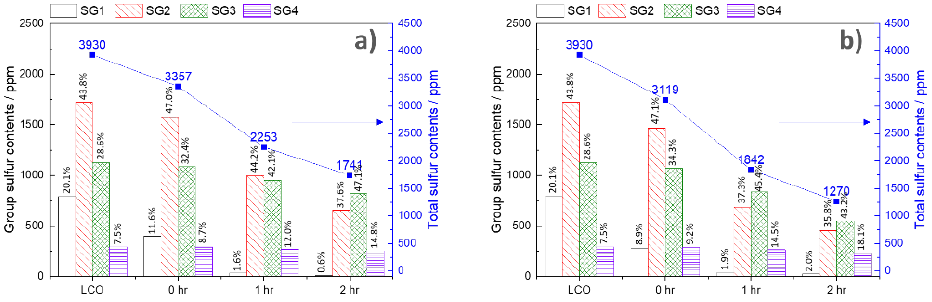
Figure 4. The fraction of the S compounds of SG1, 2, 3, and 4 in the LCO and the products after the HDS over ( a ) CoMoS and ( b ) HDS over ( a ) CoMoS and ( b ) NiMoS .